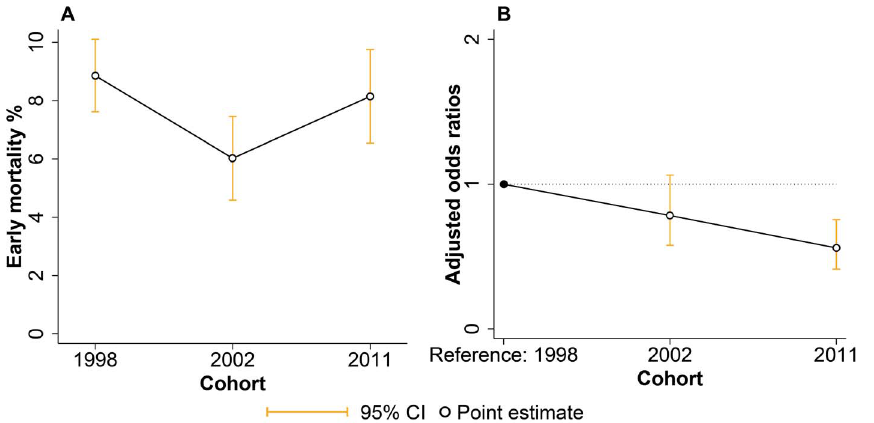
Figure 3. Unadjusted and adjusted comparison of early hospital mortality across cohorts. A. Unadjusted early hospital mortality rates across cohorts. B. Odds ratios for the 2002 and 2011 cohorts when treated as indicator variables in a multivariate logistic regression analysis with early hospital mortality as the dependent variable. The model was adjusted for sex, age, mechanism of injury and ICISS. Abbreviations: ICD International Classification of Disease, ICISS ICD-derived Injury Severity Score.